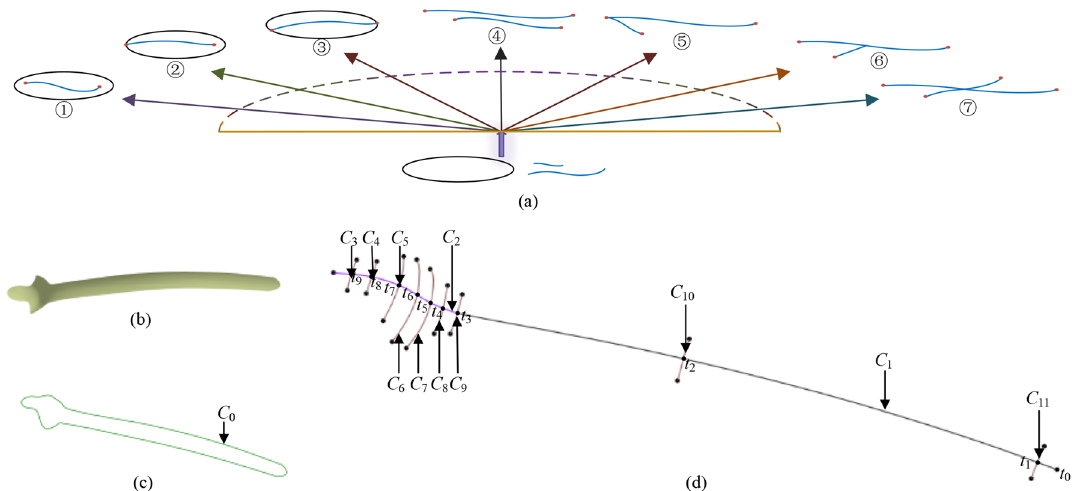
Figure 4. Skeleton-like structure of the undersurface of the eagle-shaped plate: ( a ) topological relations between feature curves: ① BI _0 type, ② BI _11 type, ③ BI _21 type, ④ II _0 type, ⑤ II _11 type, ⑥ II _12 type, and ⑦ II _13 type. ( b ) undersurface, ( c ) boundary feature curve, and ( d ) ridge curves and costal